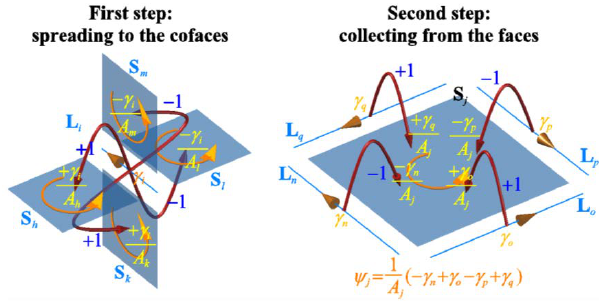
Figure 23: The coboundary process on a discrete 1-form defined on the edges of a space cell complex.